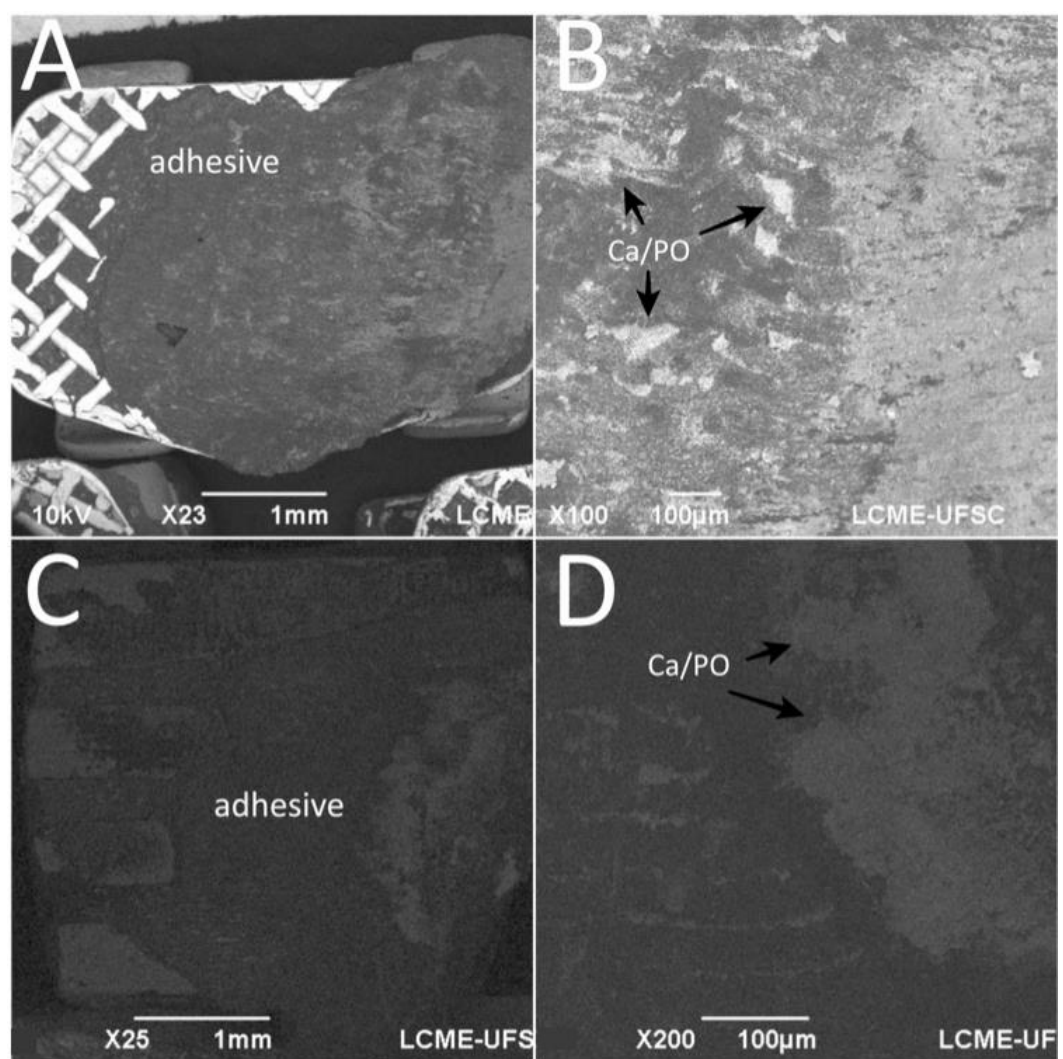
Figure 6. SEM images the bracket base after debonding from tooth enamel surfaces. EDS detected Ca and P embedded in the adhesive. Surface of the adhesive after debonding from ( A,B ) stainless-steel and ( C,D ) ceramic brackets.